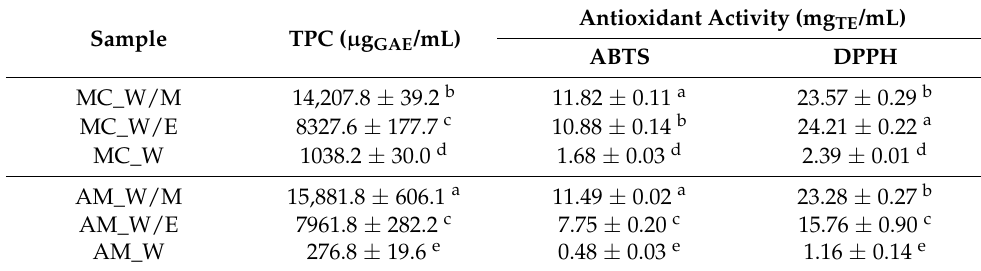
Table 4. Total phenolic content and antioxidant activity of Matricaria chamomilla L. and Achillea millefolium L. leaf extracts. The results are expressed as mean ±